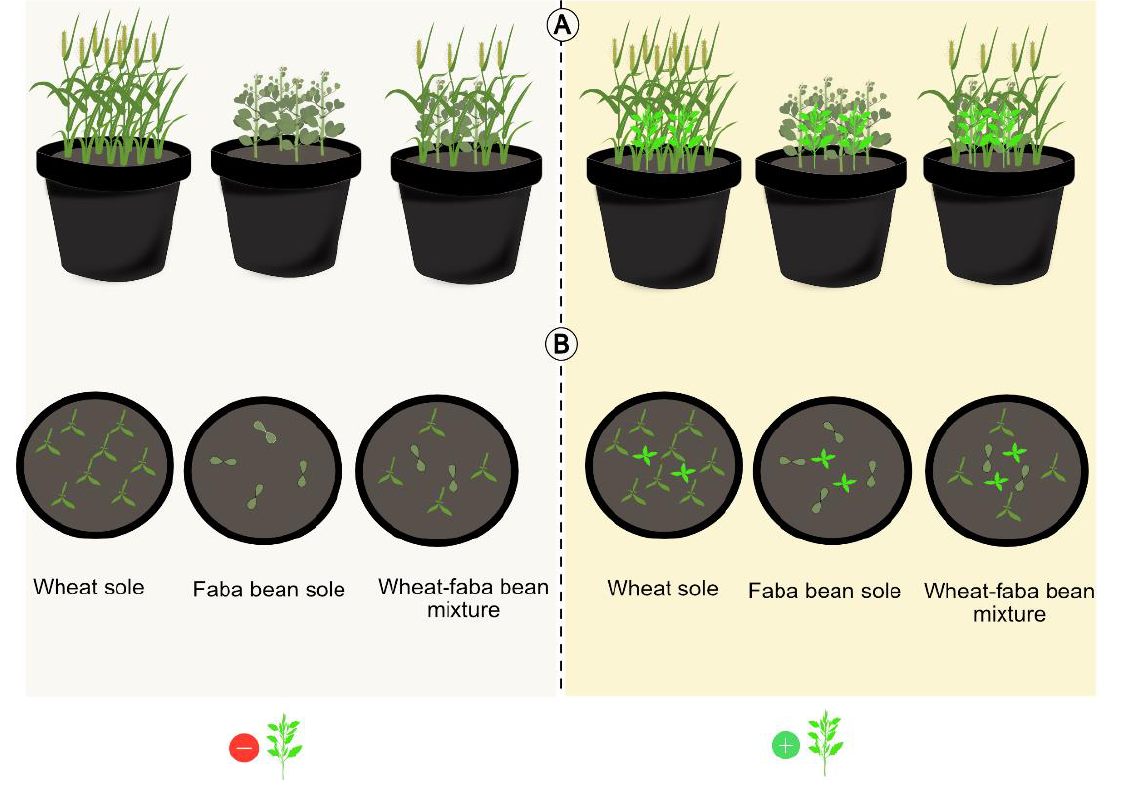
Figure 1. Illustration of a pot experimental treatment including wheat and faba bean with each crop grown as sole crop and in mixture. In half of the pots, the crop plants were grown with the weed C. album (+weed) and the other half without the weed treatment ( − weed). Two cultivars of the cereal (cv. ‘Diskett’ and ‘Alderon’) and legume (cv. ‘Boxer’ and ‘Fuego’) were used in each case. ( A ) is a two-dimensional representation of the treatments and ( B ) represents the aerial view of the pots, showing the planting design during the early growth stages.